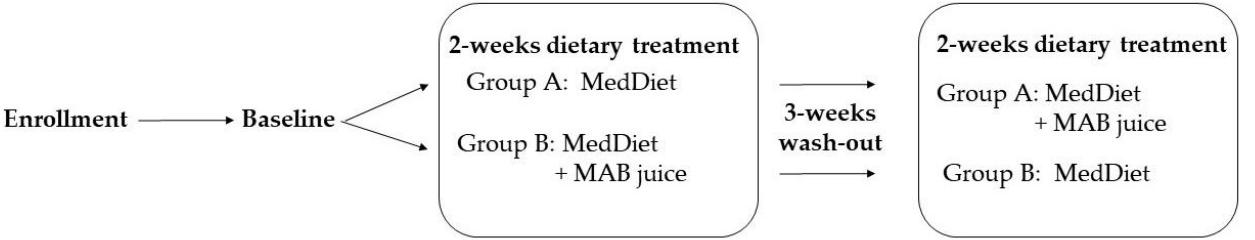
Figure 1. Study design. The randomized crossover study was divided into two treatment inter- ventions: MedDiet, Mediterranean Diet; MedDiet + MAB juice, mixed apple, and bergamot juice. Between the 2-week dietary treatment, a 3-week wash-out period was inserted. Nutritional status was evaluated at baseline. The blood sample for nutrigenomic and biochemical analysis was collected at baseline and the end of each treatment period.